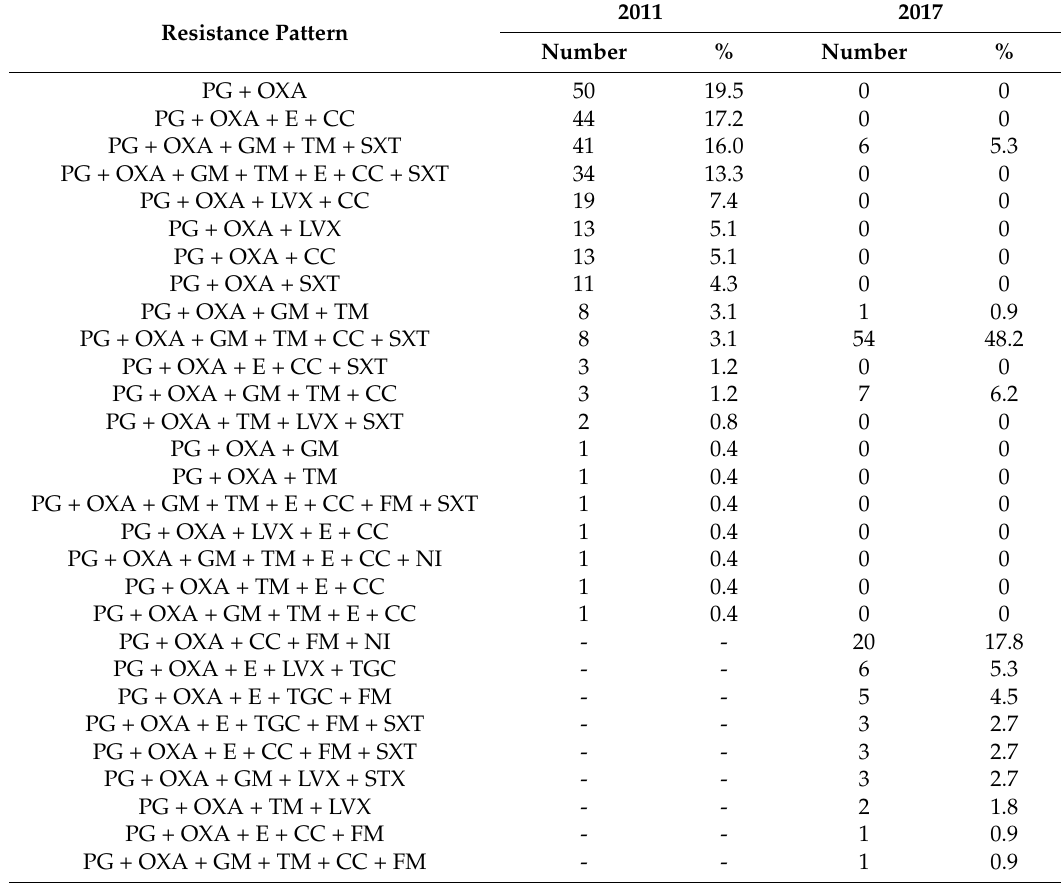
Table 2. Resistance